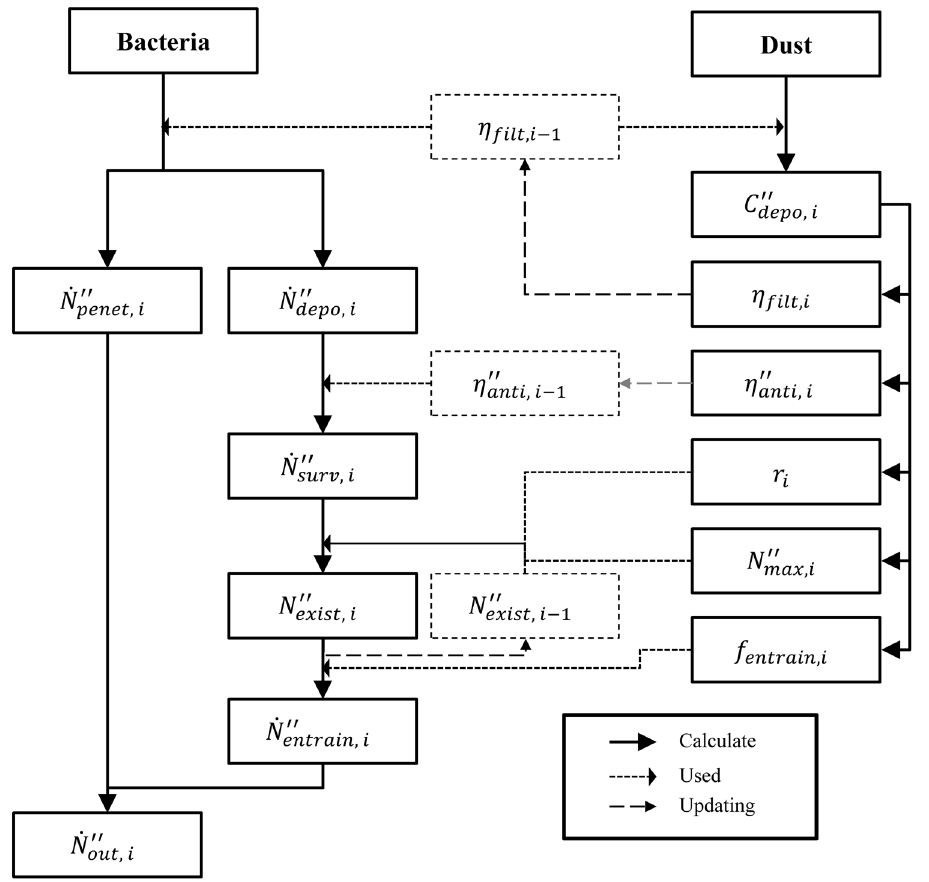
Figure 2. The calculation algorithm used to solve the equations simultaneously.